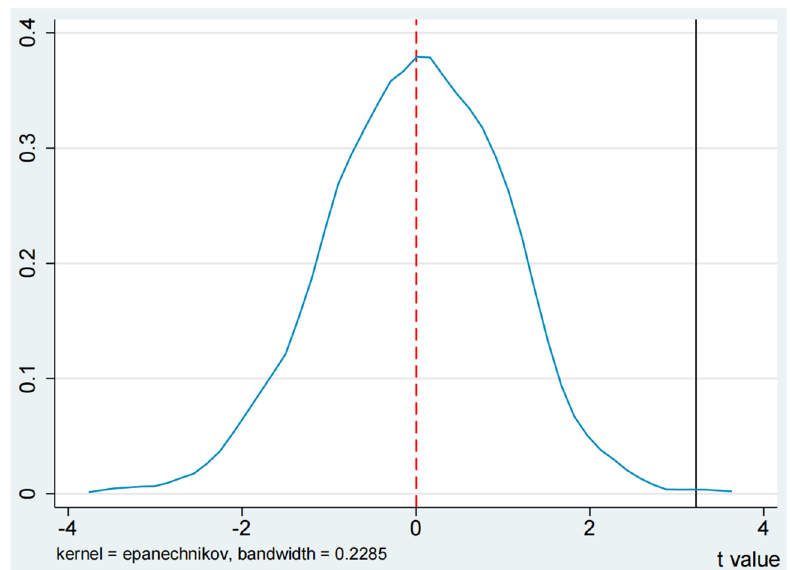
Figure 4. Placebo test. Note : The curves indicate the distribution of t-values and estimated coefficients for 1000 replicate tests, respectively. The red dashed line indicates that the results of 1000 repeated experiments basically obey the state distribution.